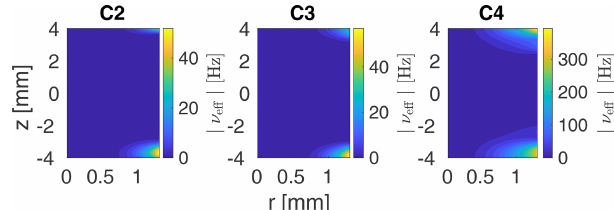
Figure 12. Effective nutation frequencies ν eff over a MAS pe- riod during FSLG decoupling as a function of the position within the 3.2mm MAS probe for C2, C3, and C4. Effective fields were extracted from interaction frame trajectories computed for a field strength of 125kHz along the magic angle and a MAS frequency of 12.5kHz. Small effective fields of up to 50Hz arise for rf ampli- tude and phase modulations alone (C2 and C3). Substantially larger fields up to 400Hz are observed for combined modulations (C4). In general, effective fields of considerable size are only obtained at the rotor edges, and even the maximum resulting magnitudes re- main small compared to the nominal rf field strength and the rotor